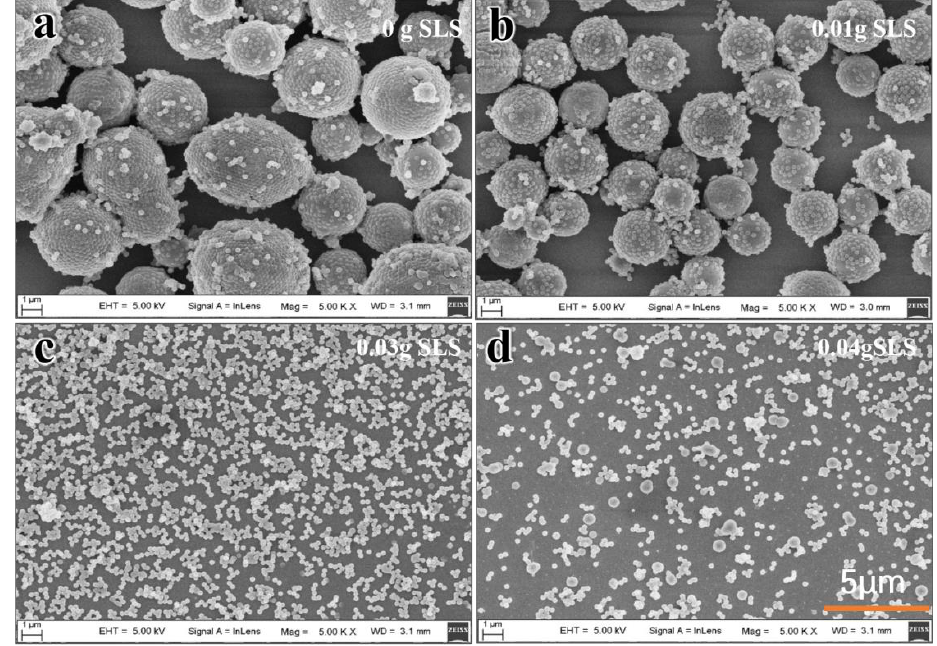
Figure 8. E ff ects of SLS contents on the SEM images of HSOS particles; ( a ) 0 g, ( b ) 0.01 g, ( c ) 0.03 g, ( d ) 0.04 g.